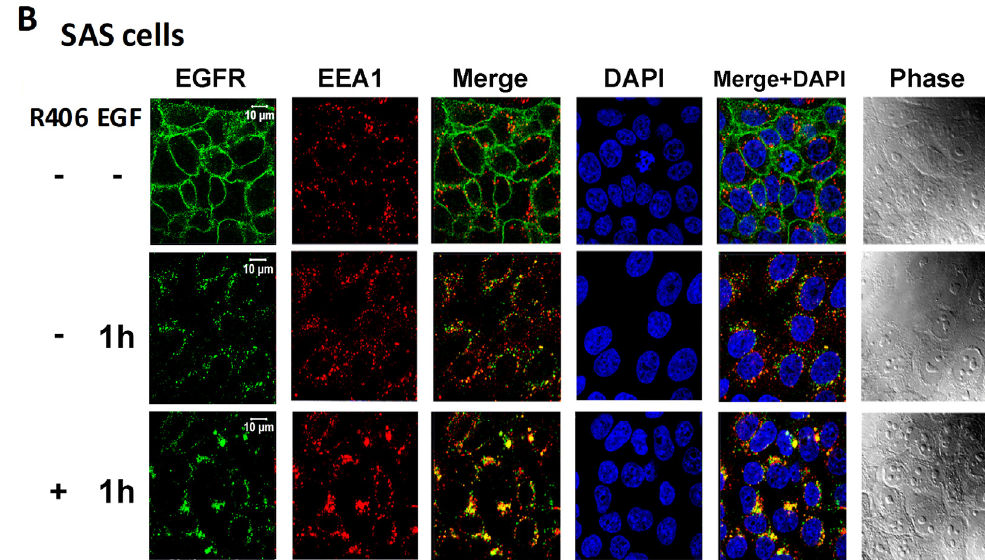
Figure 5. Syk modulates EGFR localisation under EGF treatment in A431 and SAS cells. Confocal microscopic analyses of EGFR and EEA1 (early endosome marker) localisation after treatment of EGF (50 ng / mL) for 1 h with or without the addition of R406 (1 µ M) in A431 ( A ) and SAS cells ( B ). Data are from three independent experiments.